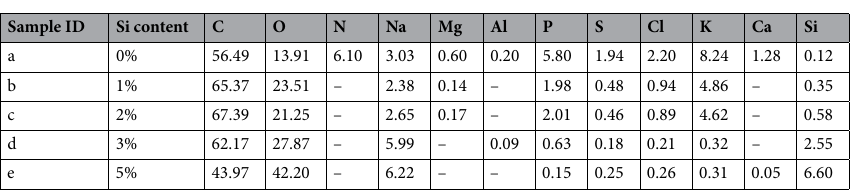
Table 3. The weight ratio of main elements in sample (a), (b), (c) and (d) in Fig. 3.